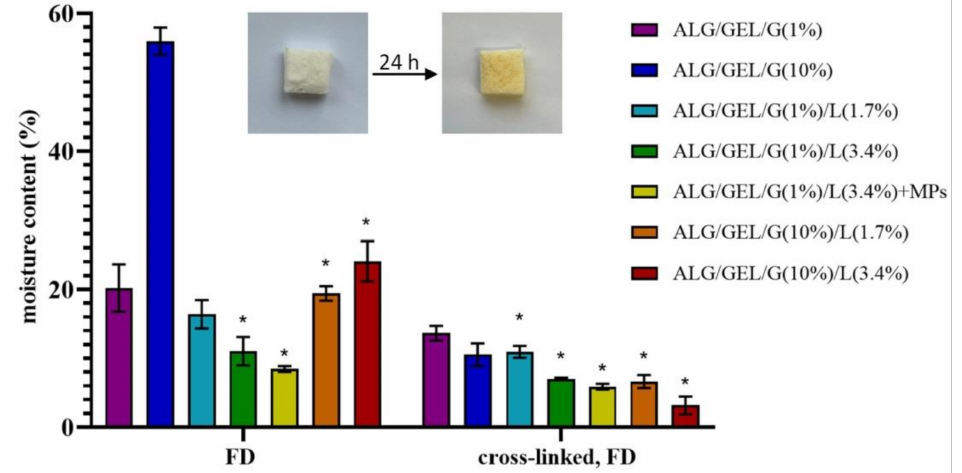
Figure 5. The moisture content of prepared materials: freeze-dried (FD) emulsions and cross-linked freeze-dried emulsion with different amounts of glycerol compared to the control samples (without lipids). The pictures present an exemplary sample (non-cross-linked ALG/GEL/G(1%)/L(3.4%)) before and after 24 h of drying at 105 ◦ C. ANOVA-one way with Dunnett’s post-hoc analysis (Cl = 95%) was performed to statistically compare the results. Significant differences compared to the control for each time were marked on the graph with (*).